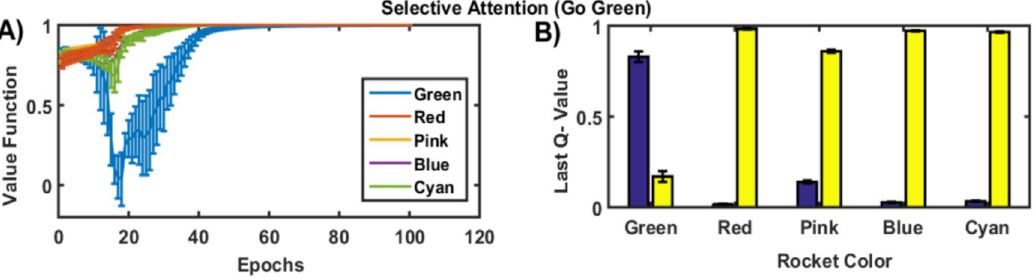
Figure 2. ( A ) The state value functions over the epochs during the training phase of the Go Green (SA) task. ( B ) The Q-value at the end of training for the Go Green task that requires selective attention to the green colored rockets while ignoring other isoluminant colors—red, pink, blue, cyan. The blue bar represents the ‘Go’ action and the yellow bar represents the ‘No-Go’